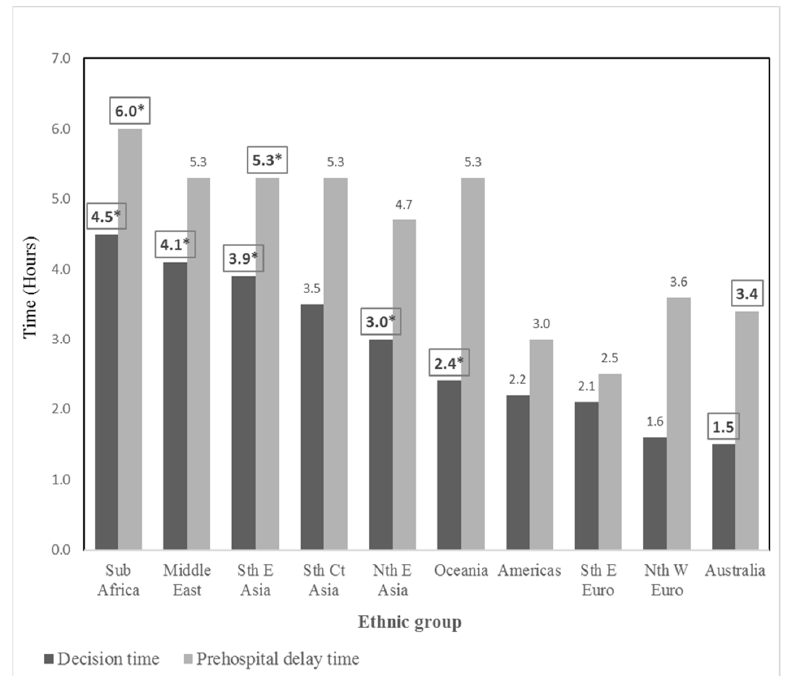
Figure 2. Comparisons of decision time (hours) and pre-hospital delay time (hours) between ethnic and Australian-born groups. Nth W Euro: North-West European, Sth E Euro: Southern and Eastern European, Nth E Asia: North-East Asian, Sth E Asia: South-East Asian, Sth Ct Asia: Southern and Central Asian, Middle East: North African and Middle Eastern, Americas: People of the Americas, Sub Africa: Sub ‐ Saharan African. Decision time was defined as the interval from the time of symptom onset to accessing the emergency response system or to initiating travel to the hospital [26]. Prehospital delay time was defined as the interval between the time of symptom onset and hospital arrival [26,29]. * Significant differences between Australian and ethnic groups, p < 0.05 by Mann– Whitney U test.